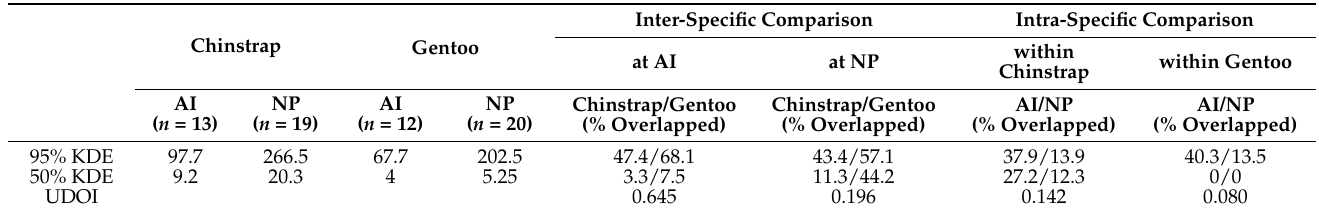
Table 1. 95% and 50% kernel density estimation (KDE) area (in km 2 ), overlapping surface intersection area (%), and utilization distribution overlap index (UDOI) values for inter- and intra-specific comparisons of sympatrically breeding Chinstrap and Gentoo penguins at Ardley Island (AI) and Nar˛ebski point (NP). Chinstrap